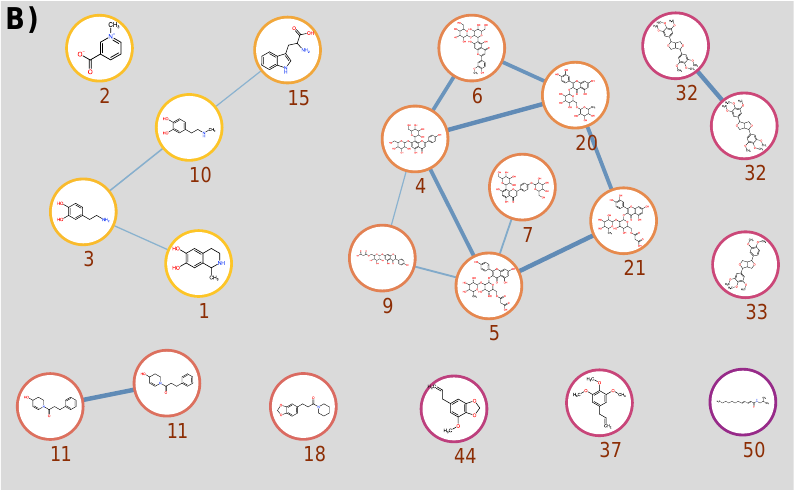
Figure 1. Molecular networking of LC-MS/MS features in kawakawa extracts. Nodes are unique features resolved by retention time or m/z. Numbers correspond to Table 2. Node borders are coloured by retention time from yellow to purple. Edge width indicates dot product 0.75–1. ( A ) The main cluster contains features that were either identified as or annotated as amides. ( B ) Features not connected to the main network of amides. Minor clusters include flavonoids, lignans and several amides. Six nodes were orphans, including several amides not connected to the main network, a lignan, phenylpropanoids and the unique compound trigonelline.